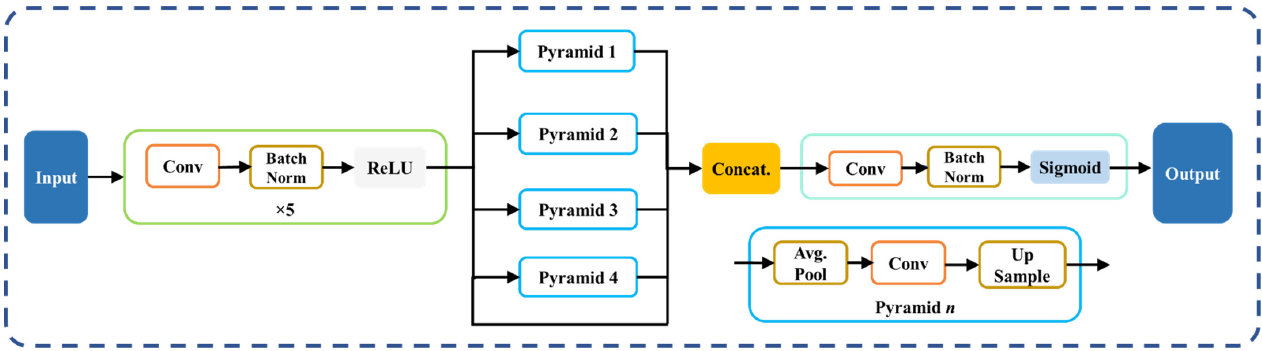
Figure 5. PSPNet’s architecture.